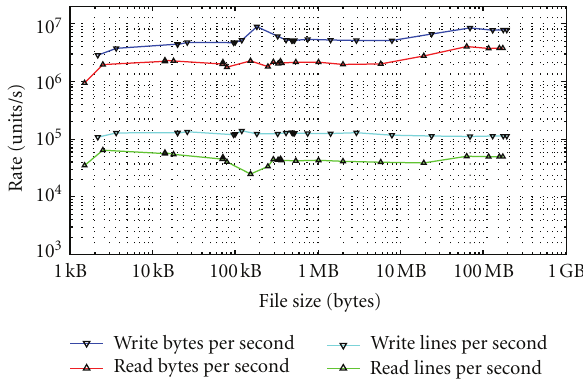
Figure 1: Torc’s Generic Netlist API I/O Performance. This log-log plot shows reasonably linear I/O performance for EDIF file sizes ranging from 1KB to 175 MB. On a 2.8 GHz quad-core Xeon, the API reads 45-thousand lines per second, and 2.3 Megabytes per second on average. The largest of these files contains over 150,000 instances and over 200,000 nets. Shape di ff erences between the two curves are most likely due to di ff erent name lengths in the EDIF